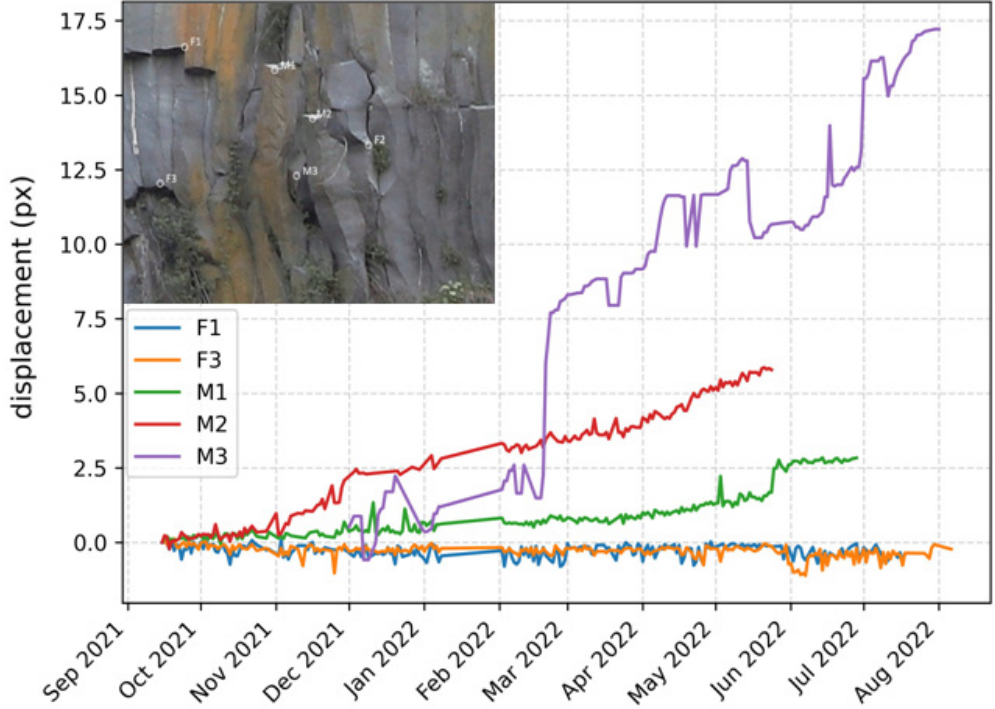
Figure 9. Situation of the control points, named with F the ones considered fixes and M the one’s mobiles. Graph of the displacement of the points from September 2021 to August 2022. mobiles. Graph of the displacement of the points from September 2021 to August